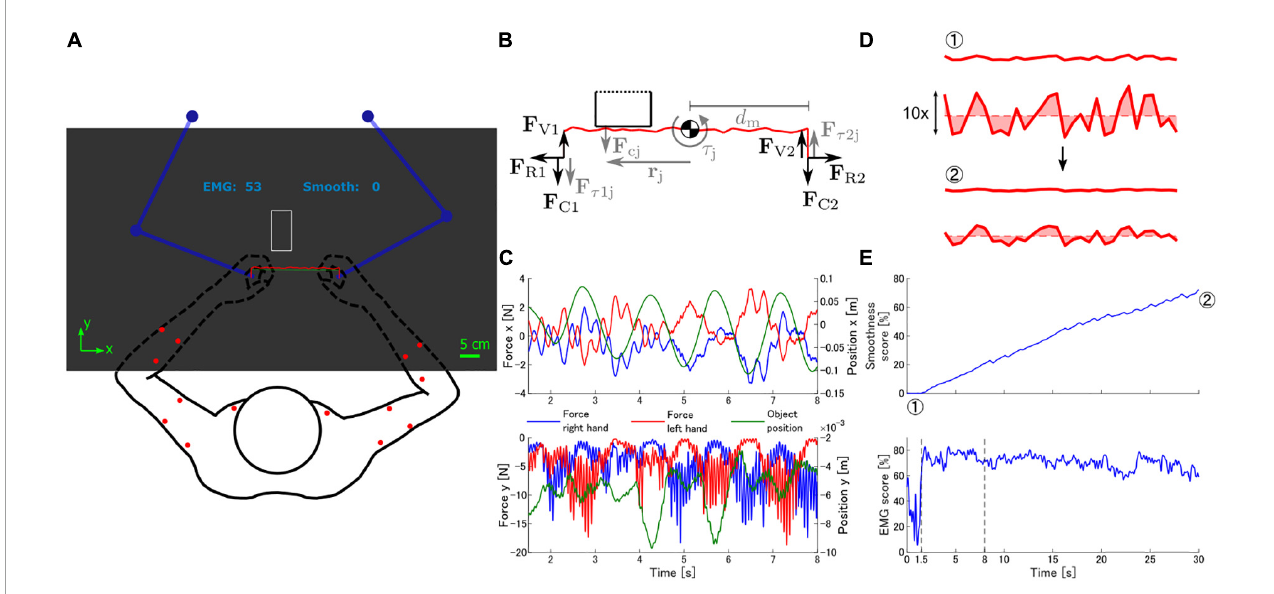
FIGURE1 Virtual task environment. (A) Experimental setup. Participants held a pair of manipulanda (blue), and moved them to control the position of the polished object (red line). The main goal of the task was to smoothen the polished object by moving it against the grinder (white rectangle). Contact between both objects caused the manipulanda to generate forces simulating the contact interaction, which also changed the shape of the polished object. The EMG and smoothness scores were displayed above the task workspace. Red dots on the arms indicate the location of the EMG electrodes. (B) Simulation of polishing task dynamics. The robotic manipulanda applied forces on the participants’ arms according to three components: forces to keep the distance between hands constant simulating a rigid object (F Ri ), contact between the polished object and the grinder (F Ci ), and vibration forces (F Vi ). Contact forces F cj originated from the overlap of the vertices of the polished object and the grinder and were applied to both arms. Contact forces also generated torque ( τ j ) around the centroid of the polished object according to the distance between the contact point and the centroid (r j ). The torque τ j was simulated by a pair of forces applied to both arms (F τ ij ). Black arrows represent the main force components (F R , F C , F V ). Gray arrows represent sub-components of the main forces. (C) Forces generated by the robotic manipulanda and position of the virtual object during a sample portion of a trial in the virtual polishing task. Notice that the magnitude of the vertical forces applied on each hand is coupled to the movement of the object along the horizontal axis. The position of the object is measured with respect to the center of the front edge of the grinder. (D) Deformation of the polished object by contact forces with the grinder. The polished object is shown with and without scaling in the vertical direction. The smoothness of the object was quantified as the area between the outline of the object and a horizontal line at the mean vertical position of all contact points. (E) Smoothness and EMG similarity scores throughout a trial. The objects in panel (D) correspond to the points indicated by circled numbers. Vertical dashed lines indicate the portion of the trial displayed in panel (C)